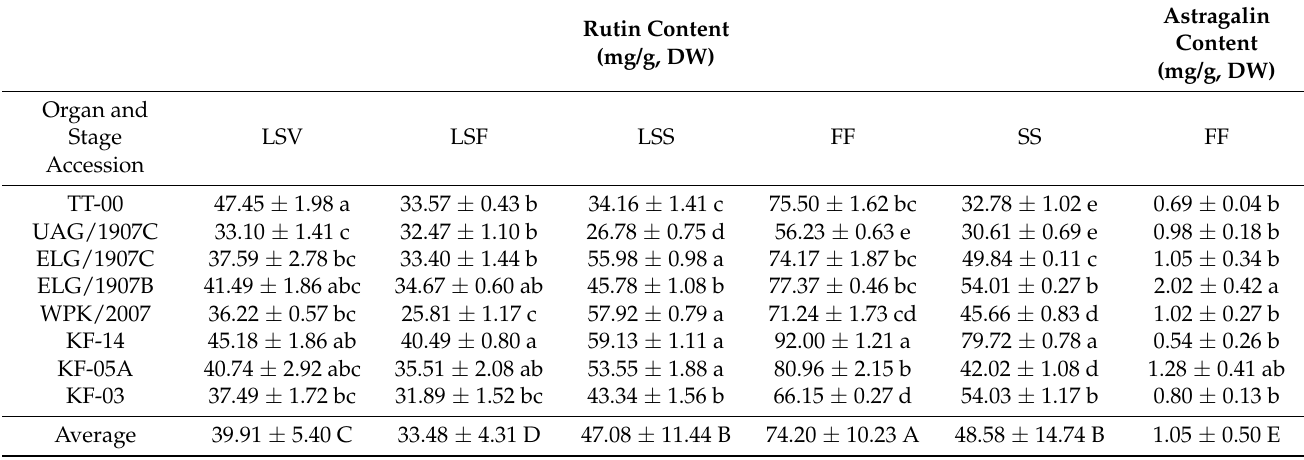
Data are presented as means ± standard deviation, n = 3, in each accession. LSV = leaves and stem in the vegetative stage; LSF = leaves and stem in the flowering stage; LSS = leaves and stem in the seed set stage; FF = flower in the flowering stage; SS = siliques in the seed set stage. Capital letters indicate significant variations in the average rutin content in organs across the different growth stages and small letters in specific columns indicate rutin variations among the accessions. Means in the same column followed by the different small letters indicate significant differences in the accessions rutin content, while averages with different capital letters indicate significant differences in the rutin content for the organs at p <